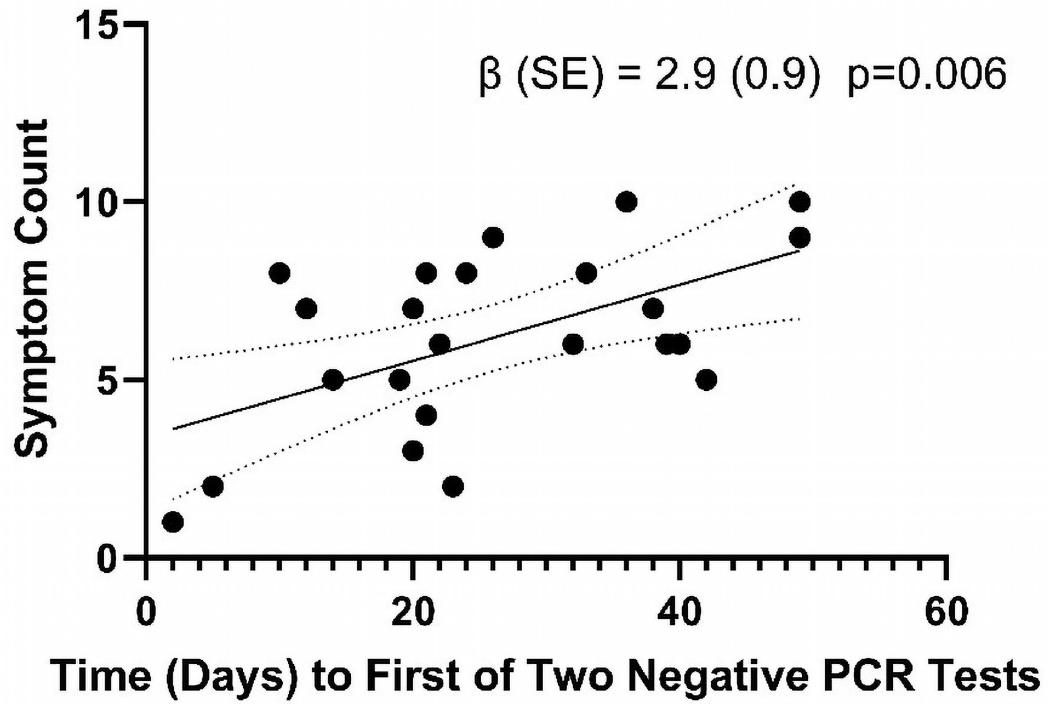
Fig 3. Duration of positive RT-PCR test for SARS-CoV-2 according to number of symptoms. Duration of positive RT-PCR test was positively associated with number of symptoms. Patients with more symptoms had a positive RT-PCR test significantly longer than patients with fewer